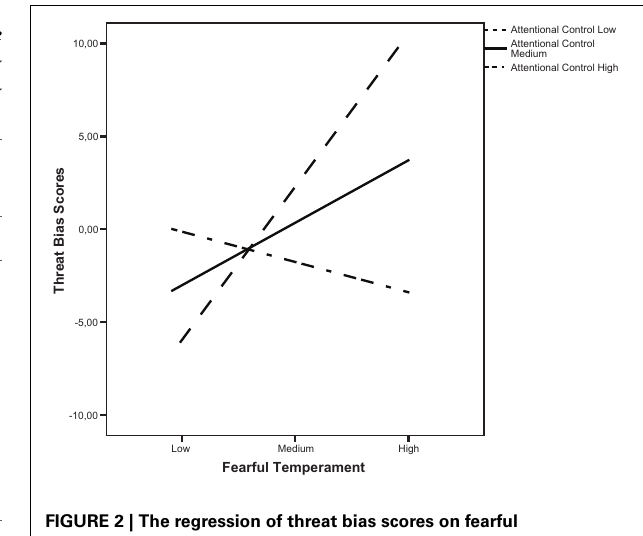
FIGURE 2 | The regression of threat bias scores on fearful temperament and attentional control (straight lines represent expected